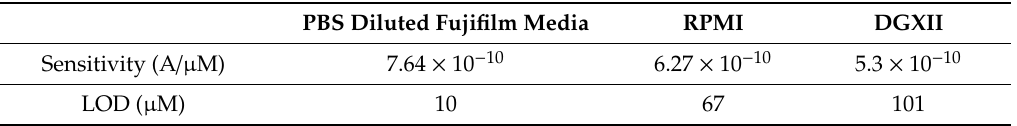
Table 1. Analytical performance of the developed biosensor in the di ff erent